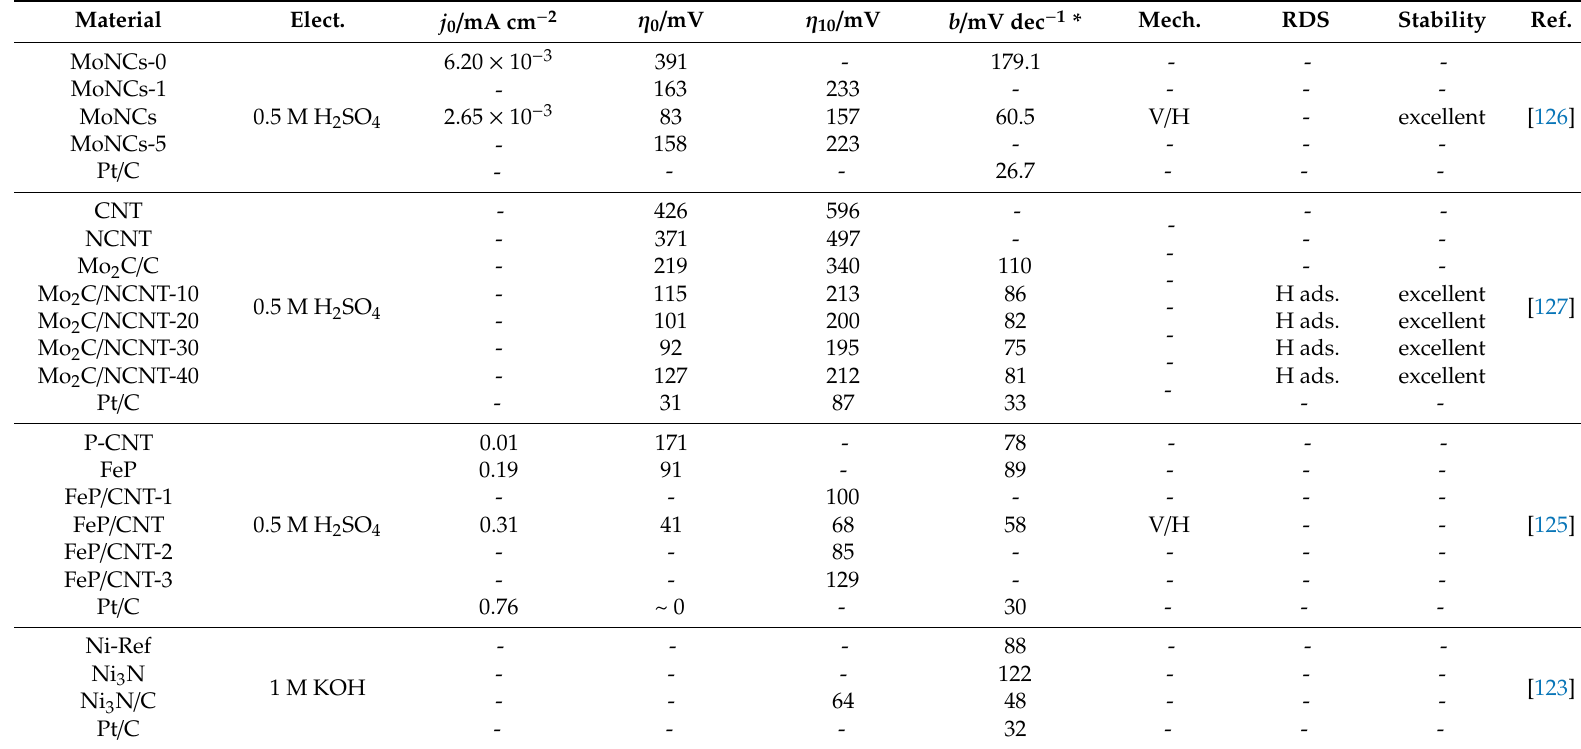
Table A2. Supported carbides and